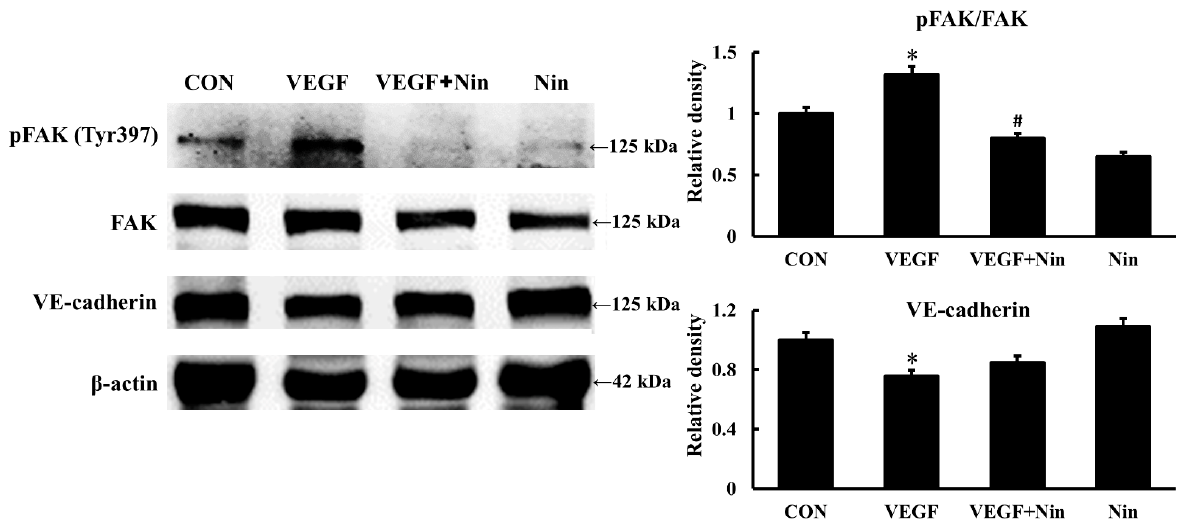
Figure 5. Nintedanib suppresses VEGF-induced FAK activation. Western blot and semi-quantitative analysis of protein expression in HPMECs treated with VEGF or nintedanib alone or in combination. Western blot was performed using the indicated antibodies. n = 3–5 in each group. CON, control; FAK, focal adhesion kinase; HPMEC, human pulmonary microvascular endothelial cell; Nin, nintedanib; pFAK, phosphorylated focal adhesion kinase; VE-cadherin, vascular endothelial cadherin; VEGF, vascular endothelial growth factor. Data are presented as mean ± standard error of mean. * p < 0.05 vs. control, and # p < 0.05 vs. VEGF (two-tailed Student’s t-test).